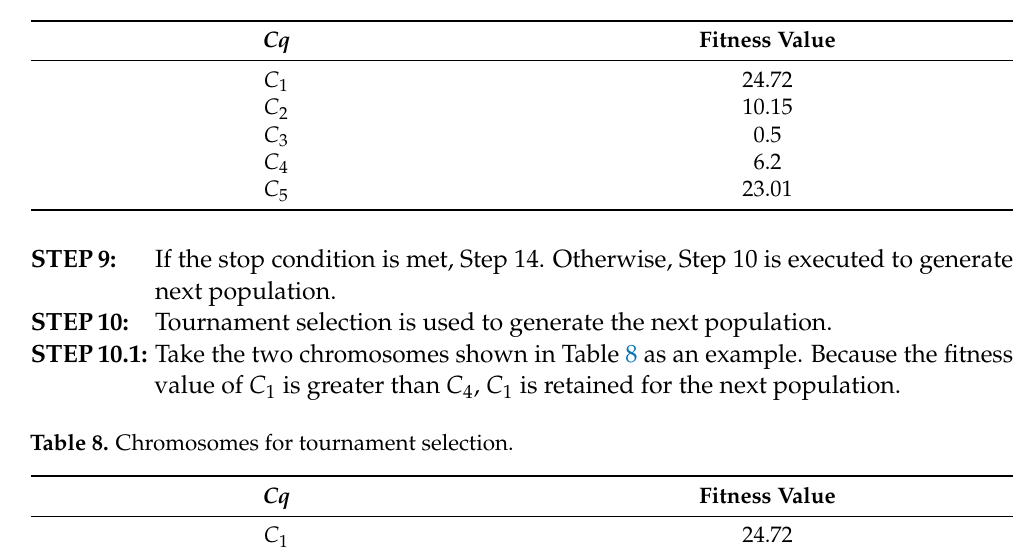
Table 7. Fitness values of chromosomes.